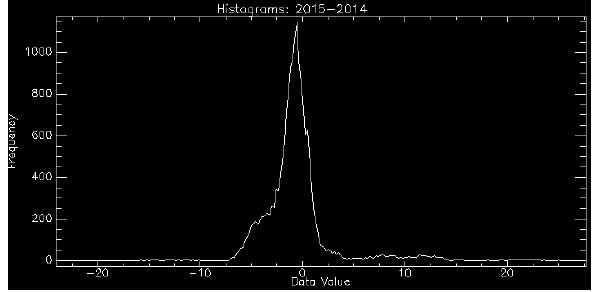
Figure 13. Histogram of the difference between the 2015 and 2014 depth